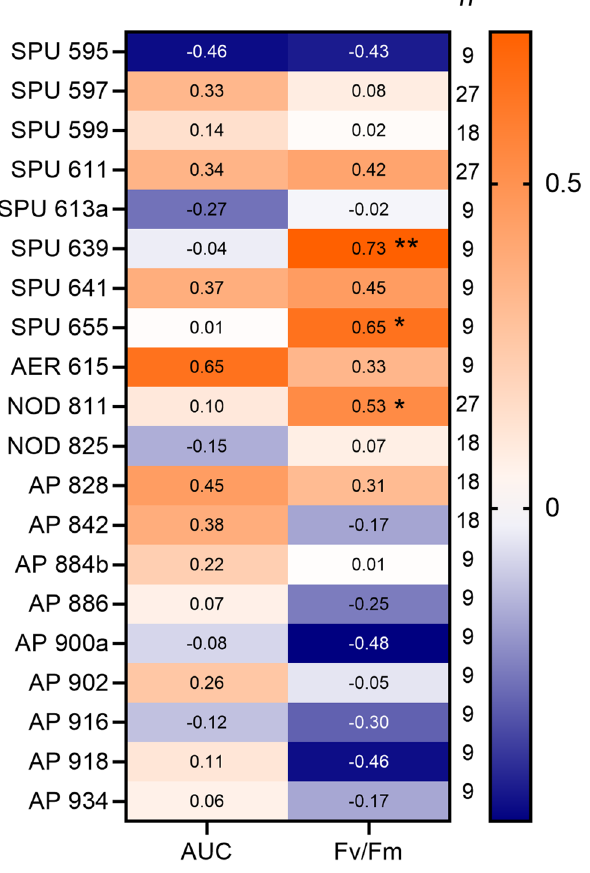
Figure 5. Spearman rank correlations between the physiological parameters (AUC: area under the curve, representing the cumulative biomass; Fv/Fm: photosynthetic efficiency) and NRPs measured in the mono- and co-cultures, all strains, and treatments included. The numbers in the cells are rho values, and the asterisks denote p < 0.05 (*) and p < 0.01 (**); n values indicate number of